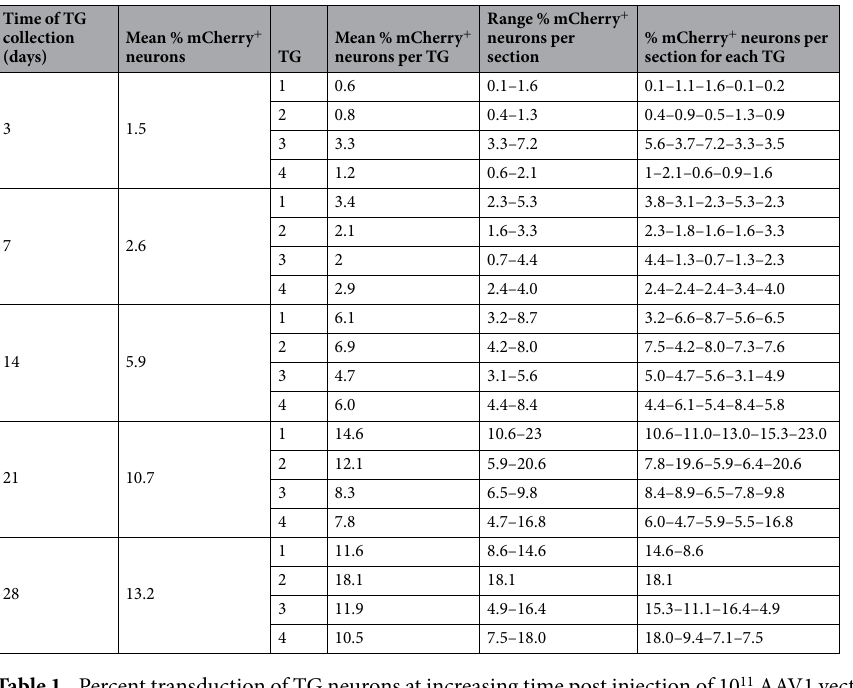
Table 1. Percent transduction of TG neurons at increasing time post injection of 10 11 AAV1 vector genomes.